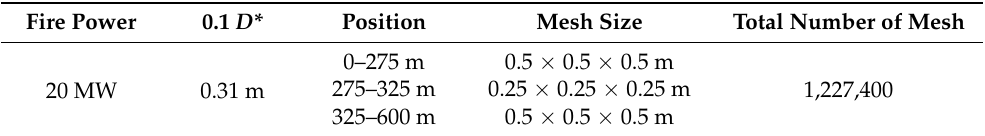
Table 1. Distribution of mesh